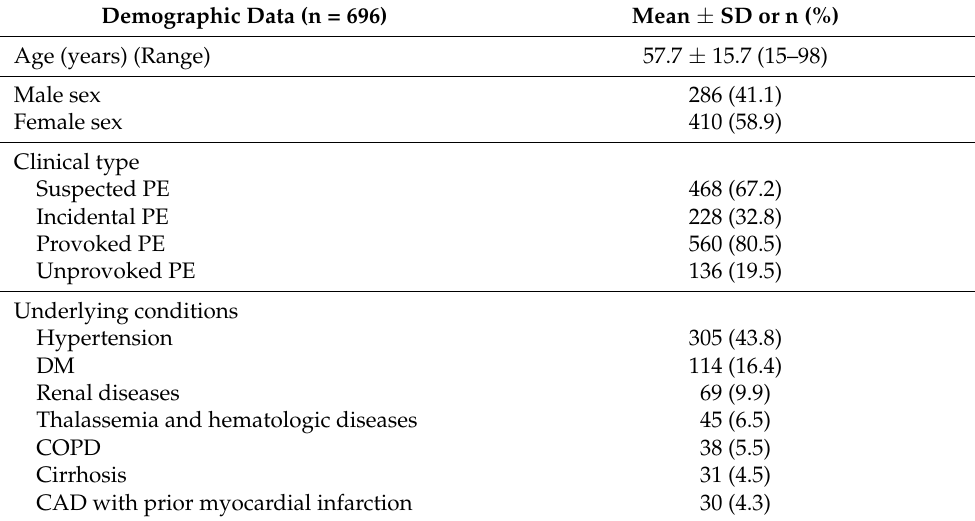
Table 1. Demographic data, clinical and underlying